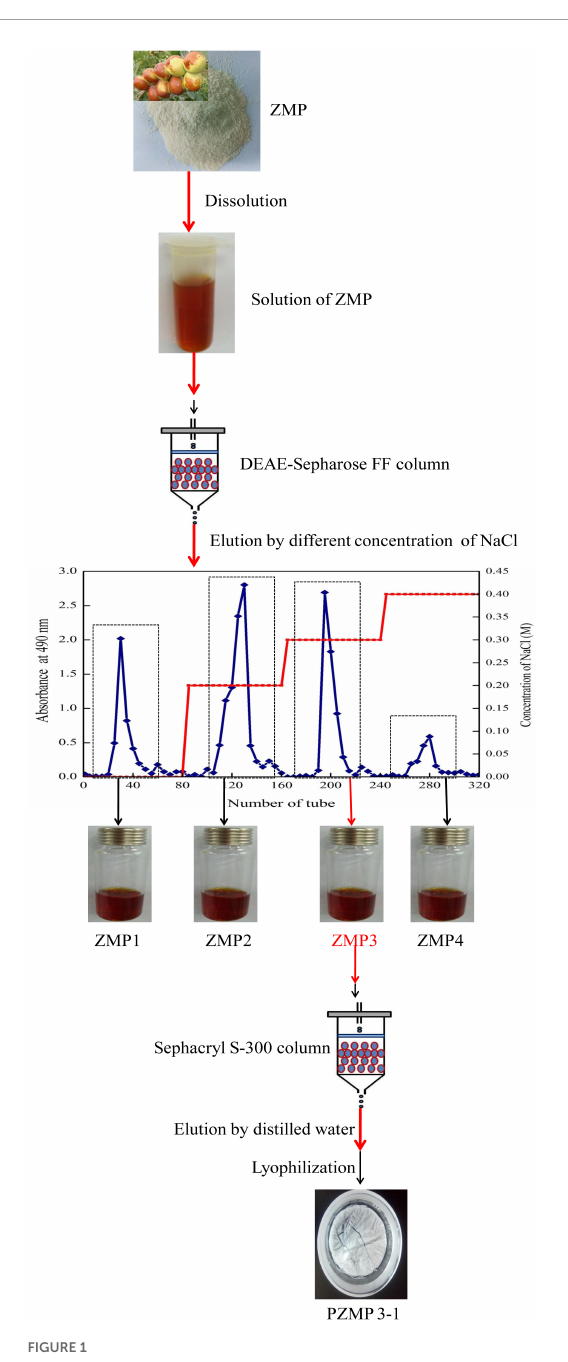
FIGURE1 The PZMP3-1’s separation flow diagram.